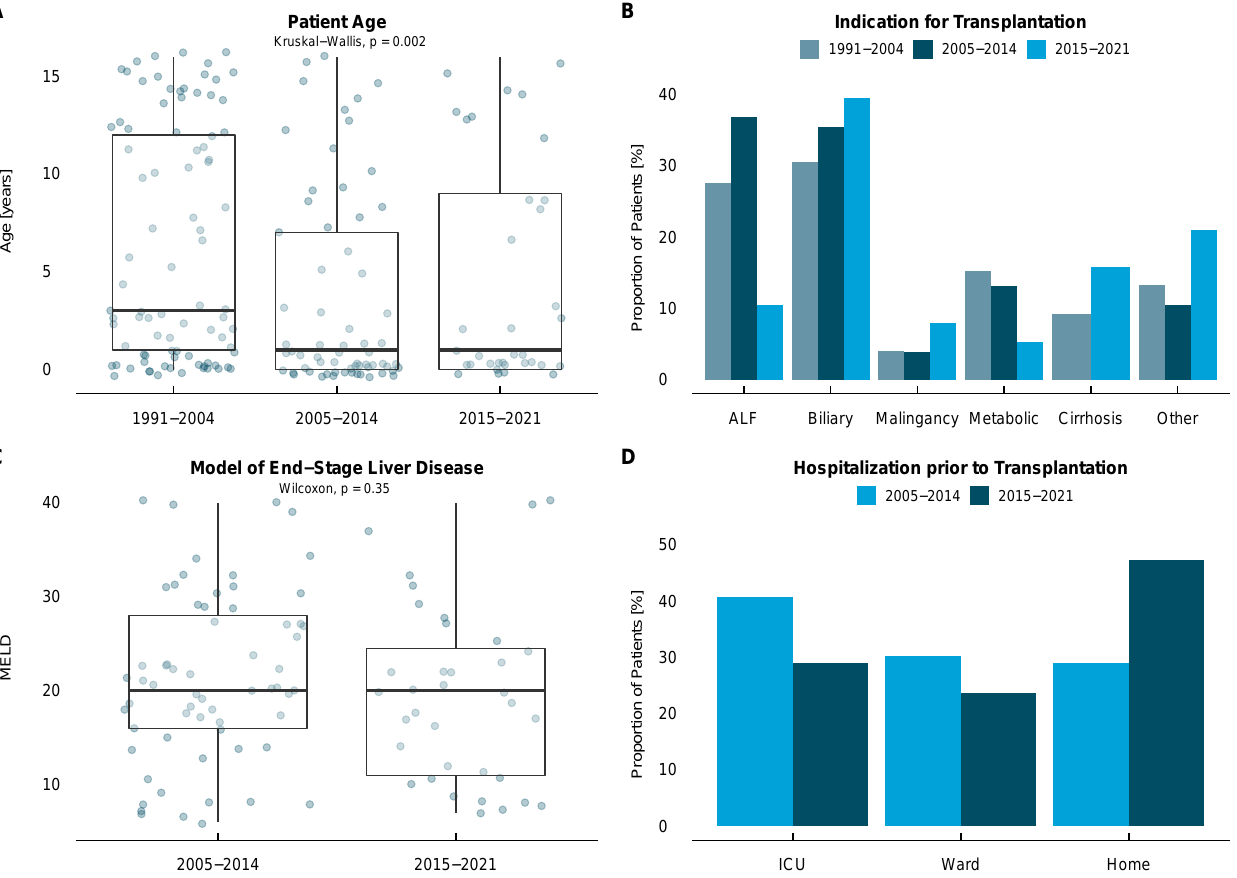
Figure 1. Univariate analysis of patient data. ( A ) Patient age over the three historic cohorts. ( B ) Indica- tion of pediatric liver transplantation. ( C ) Laboratory Model of End-Stage Liver Disease (MELD) ( D ) Hospitalization prior to